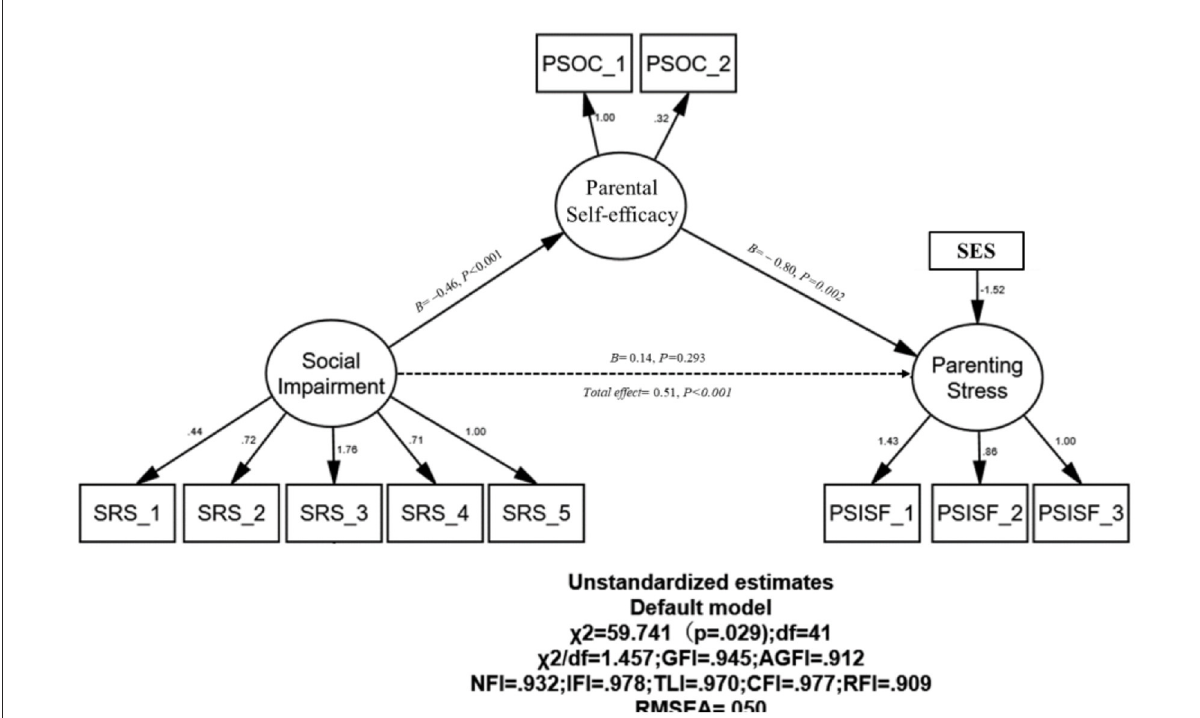
FIGURE1 Mediation model examining the association between child social impairment and parenting stress through parental self-efficacy. SRS, The Social Responsiveness Scale; PSOC, Parental Self-efficacy of Competence Scale; PSISF, Parenting Stress Index-Short Form; SES, Socioeconomic status. The dashed line represents a non-significant